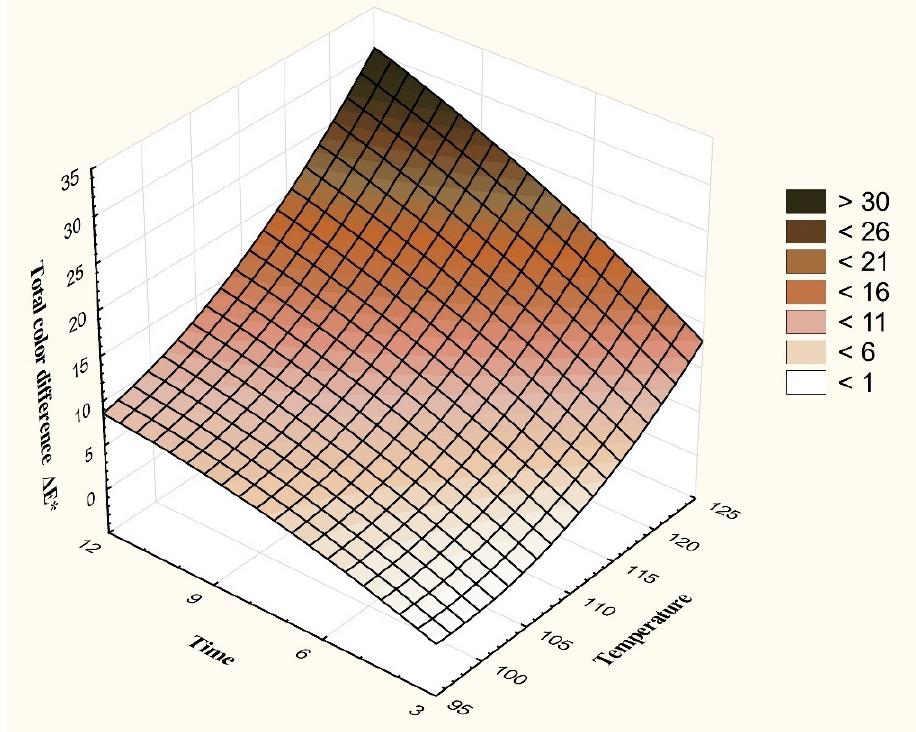
Figure 4. Dependence of the total color difference Δ E* on the temperature of saturated water steam and the time of thermal modification.